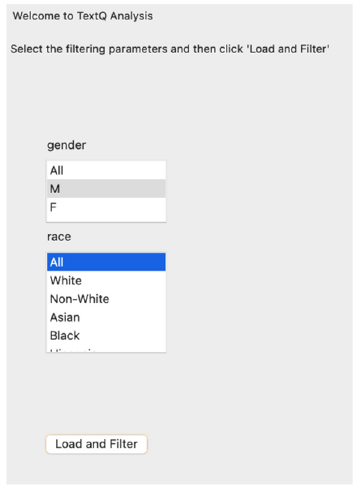
Figure 7. TextQ Options Pane.